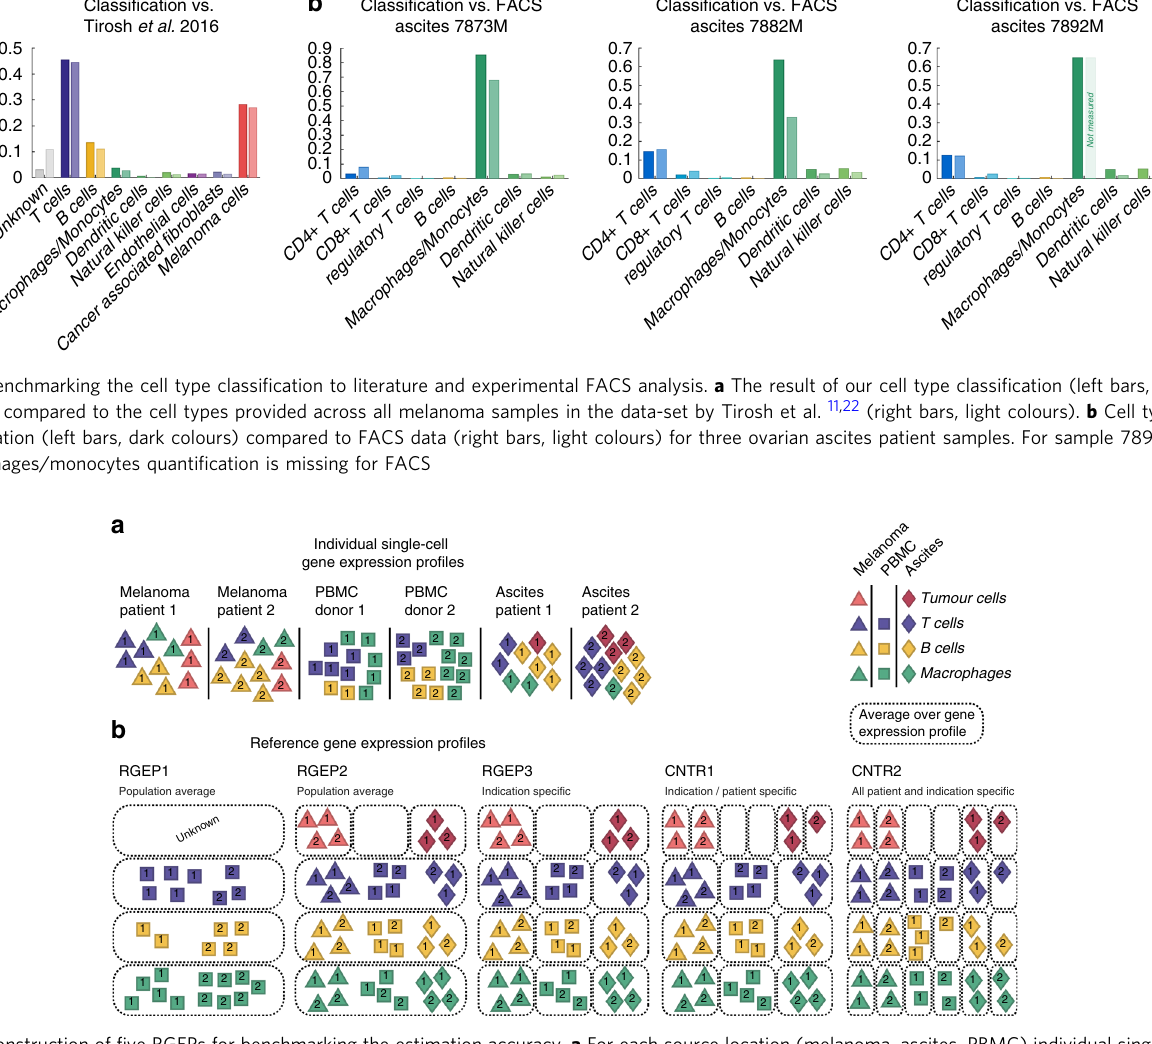
Fig. 3 Construction of fi ve RGEPs for benchmarking the estimation accuracy. a For each source location (melanoma, ascites, PBMC) individual single cell gene expression pro fi les are collected for multiple patients. Colours indicate the cell type, numbers indicate the patient sample and symbols show the source location (triangles for melanoma, squares for PBMCs, and diamonds for ascites). b Construction of REGPs from three single cell data-sets: RGEP1 bases on the population average of PBMC data; RGEP2 takes all three source locations into account; RGEP3 is indication-speci fi c and location-speci fi c; CNTR1 is patient-speci fi c for tumour cells and indication/location-speci fi c for non-malignant cells; CNTR2 is fully patient-speci fi samples experimentally with fl uorescence-activated cell sorting (FACS). As depicted in Fig. 2 our classi fi cation is in line with previously published results and our FACS measurements.